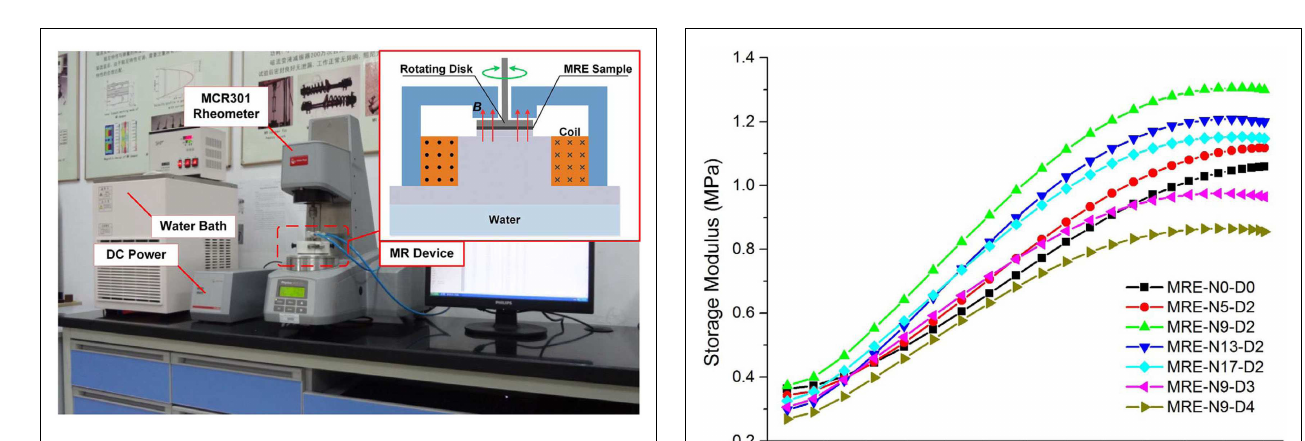
FIGURE 3 | Configuration of testing system .